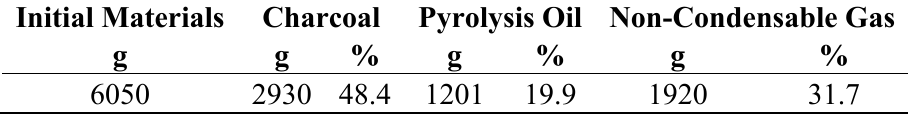
Table 3. MGW pyrolysis yield products test